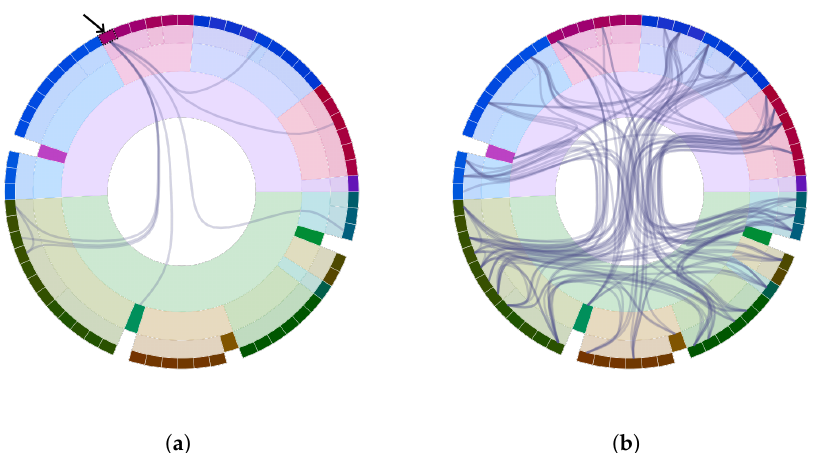
Figure 11. Computation of the ego network of the node pointed by the arrow. ( a ) One-step ego- network. ( b ) Three-step